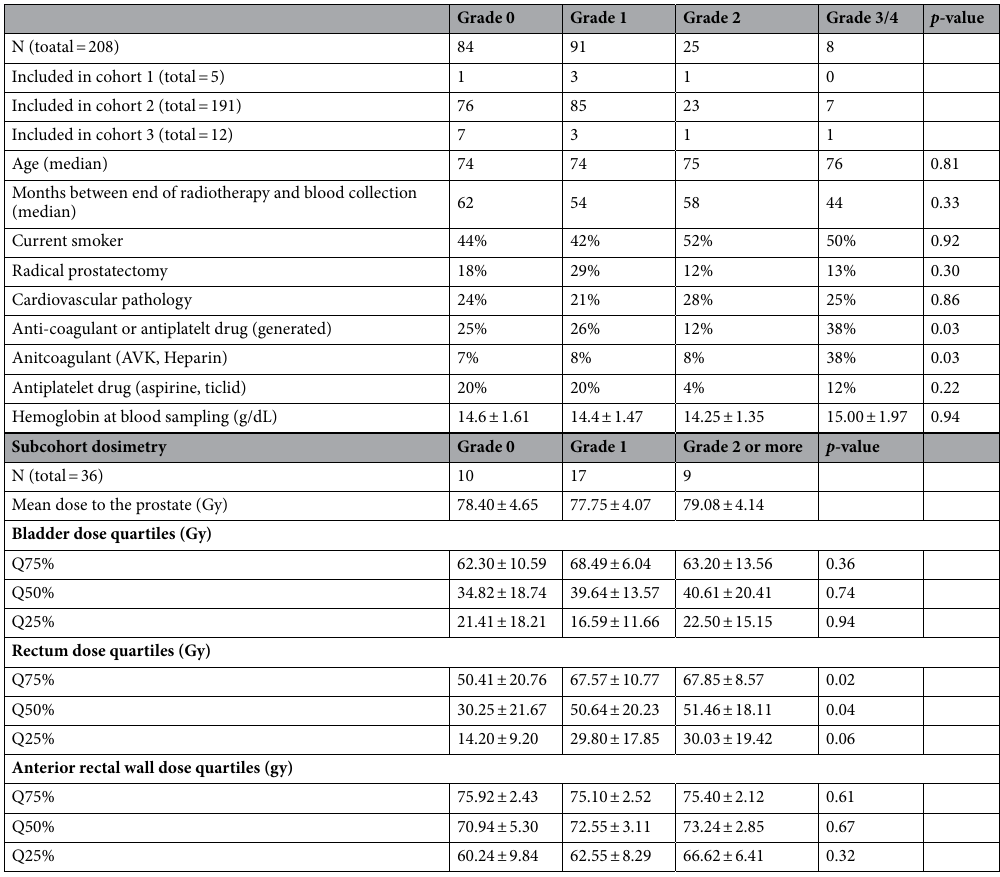
Table 1. Patient